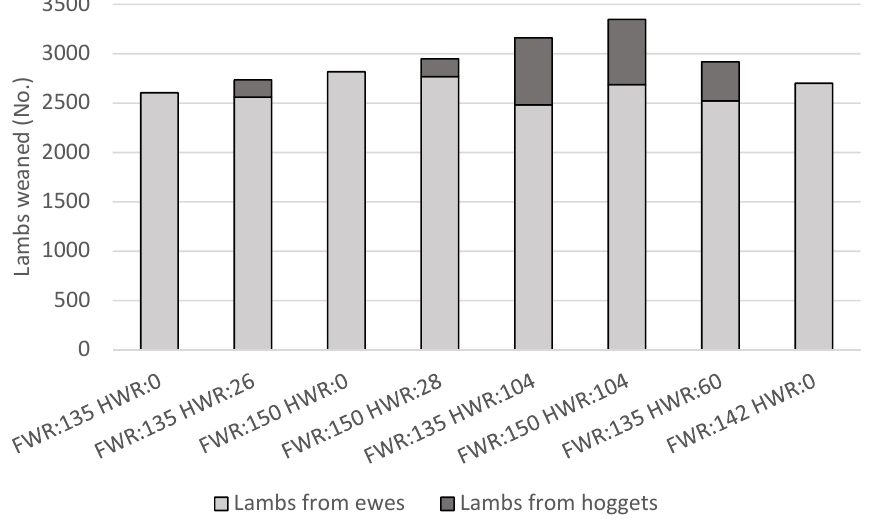
Figure 2. Weaned lambs from mature ewes (2 to 6 years old) and weaned lambs from hoggets (1 year old), for scenarios with combinations of varying weaning rates (lambs weaned per ewe presented for breeding) of mature ewes (FWR) and hoggets (HWR).